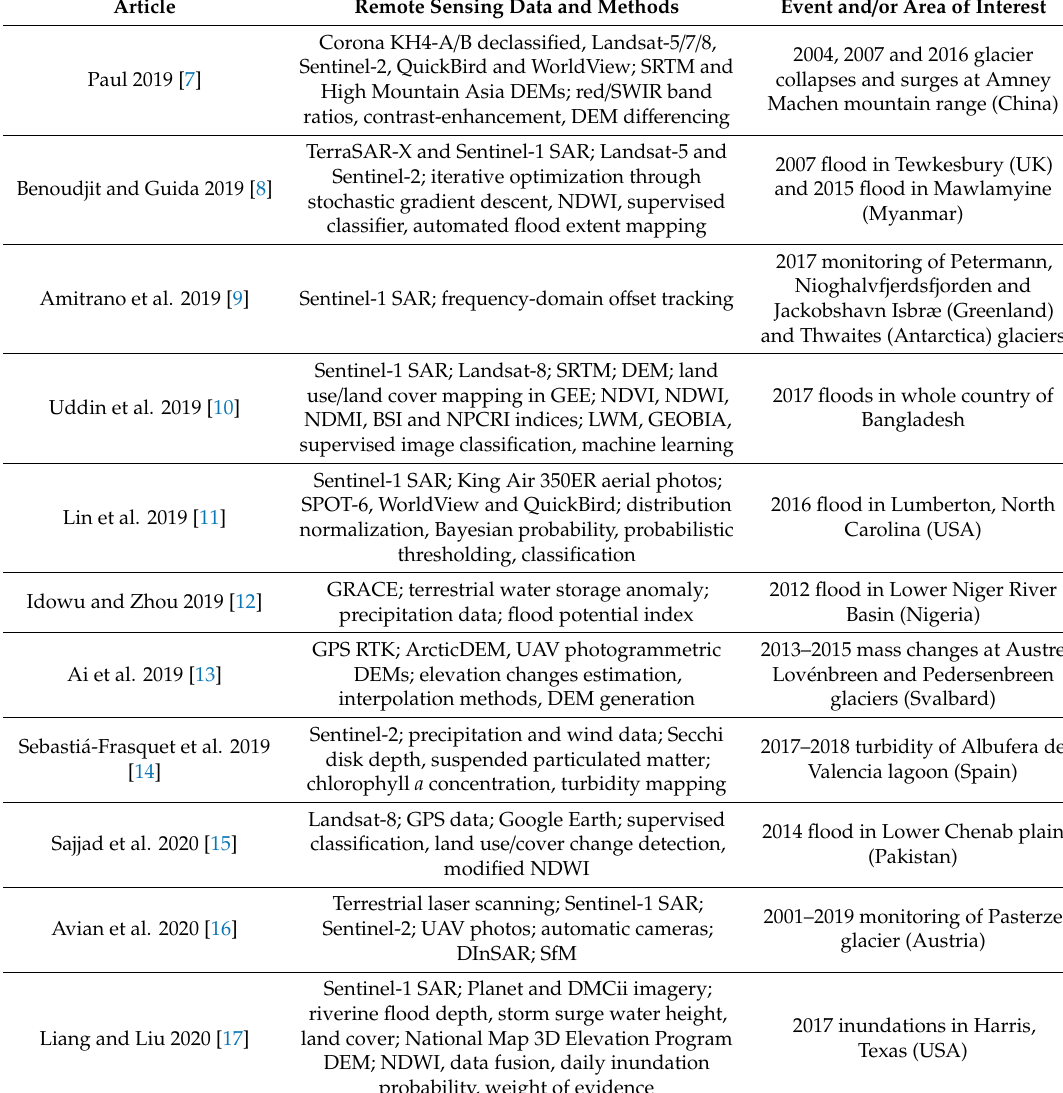
Table 1. Remote sensing data, methods and areas of interest discussed in the 11 research papers composing the Special Issue (sorted in ascending order, according to the publication date). Notation: BSI, Bare Soil Index; DEM, Digital Elevation Model; DInSAR, Di ff erential Interferometric SAR; GEE, Google Earth Engine; GEOBIA, GEographic Object-Based Image Analysis; GPS, Global Positioning System; GRACE, Gravity Recovery and Climate Experiment; LWM, Land and Water Mask; NDMI, Normalized Di ff erence Moisture Index; NDVI, Normalized Di ff erence Vegetation Index; NDWI, Normalized Di ff erence Water Index; NPCRI, Normalized Pigment Chlorophyll Ratio Index; RTK, Real-Time Kinematic; SAR, Synthetic Aperture Radar; SfM, Structure from Motion; SRTM, Shuttle Radar Topography Mission; SWIR, Short Wave InfraRed; UAV, Unmanned Aerial